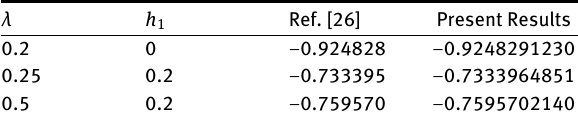
Fig. 20: Influence of h 3 on concentration field Table 3: Validation of the results of f (cid:48)(cid:48) (0) with Ref. [26] for Newton- ain